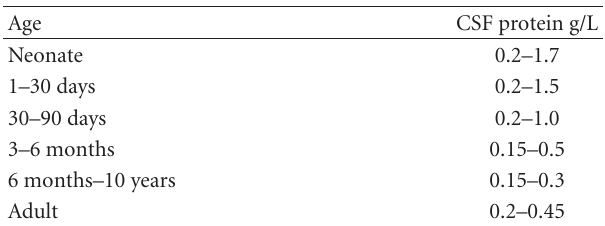
Table 3: Data adapted from Fishman